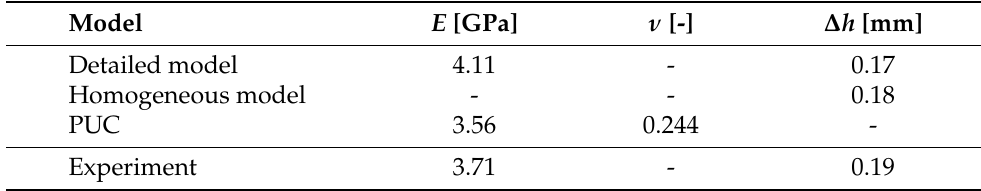
Table 7. Results from initial comparative study on DT-2 geometry.